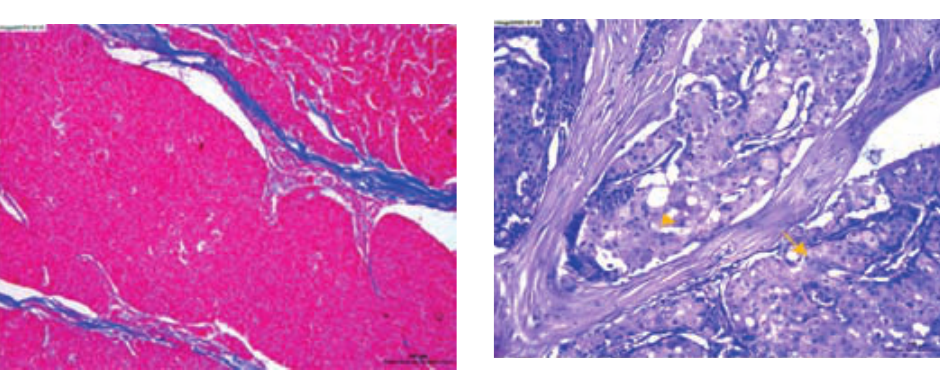
Fig. 5. Hepatoid gland carcinoma- pleomorphic cells with abundant eosinophilic and vacuolated cytoplasm and large nuclei with prominent nucleoli. Multinucleated cell(arrow) and mitotic figure (arrow head) (H&E x 200)